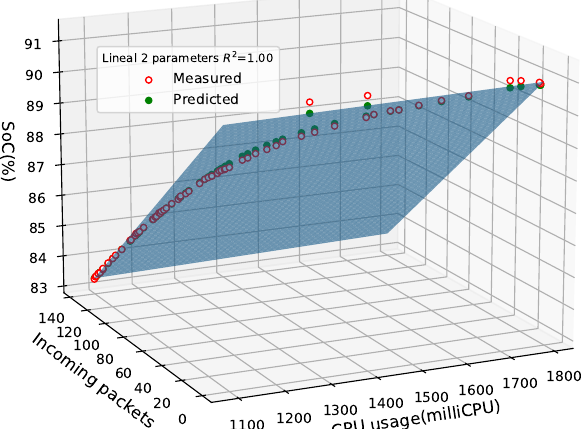
Figure 9. Linear regression model with CPU usage and incoming packets as predictors for the controller